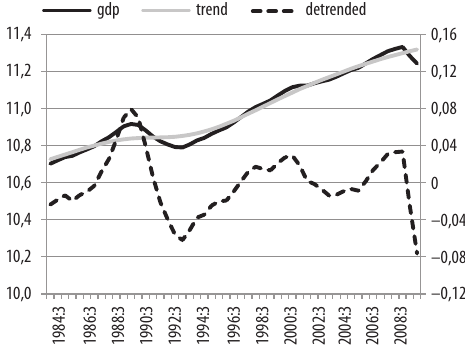
Fig. 5. Logarithm of the original gdp time series with trend and detrended series generated